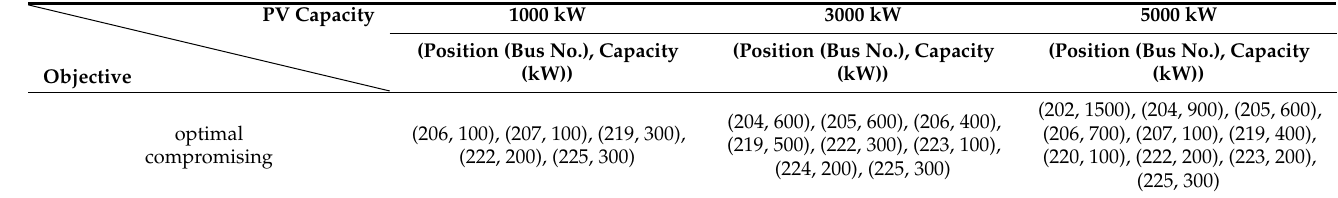
Figure 11. Optimal PV placements for Feeder2-Based simulation. ( a ) PV installed capacity 1000 kW; ( b ) PV installed capacity 3000 kW; ( c ) PV installed capacity 5000 kW. Table 4. Summary of the optimal PV placements of the Feeder1-Based model for different objec- tives.